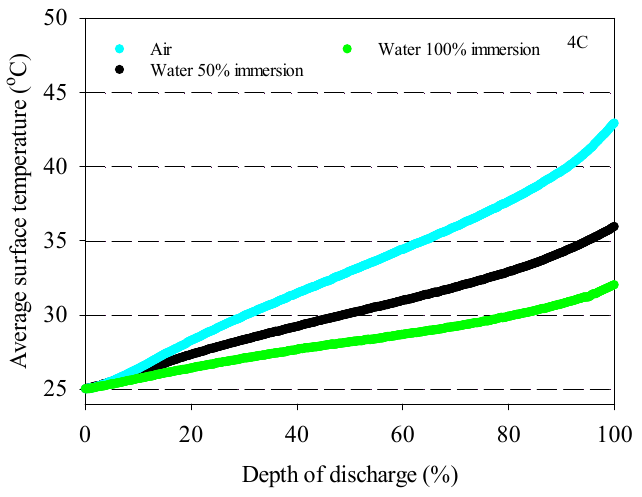
Table 3. The minimum temperatures at end of discharge for different operation conditions.